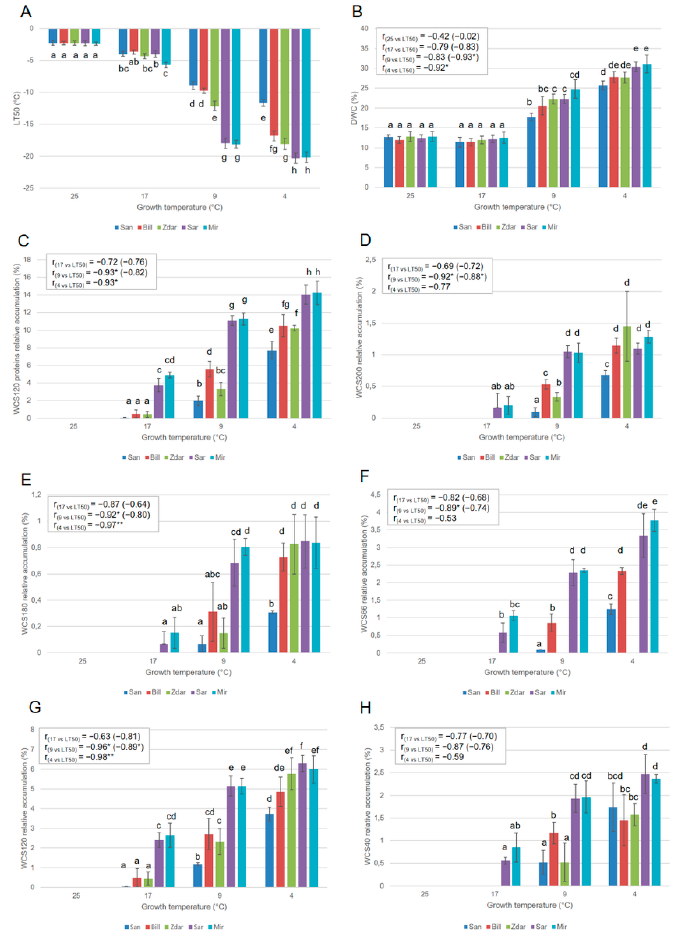
Figure 2. The values of the ( A ) LT50, ( B ) dry weight content (DWC), ( C ) sum of the WCS120 proteins (WCS120 proteins), ( D ) WCS200, ( E ) WCS180, ( F ) WCS66, ( G ) WCS120 and ( H ) WCS40 in the wheats cultivated under different growth temperature (25, 17, 9, and 4 °C). Presented data are mean values calculated from 6 repetitions. Error bars indicate SD, different letters indicate significant differences at 0.05 level using ANOVA analysis followed by Duncan’s multiple range test. One asterisk (*) and two asterisks (**) indicate statistical significance of correlation coefficient at p = 0.05 and 0.01, respectively. “20, 17, 9, 4 vs. LT50”—value for correlation between value of sample cultivated under 25, 17, 9, and 4 °C treatment and LT50 revealed in the treatment. Bracket in the linear correlation coefficient line indicates the correlation between the sum of WCS120 proteins and maximal LT50 (i.e., from 4 °C treatment). r—Pearson correlation coefficient.